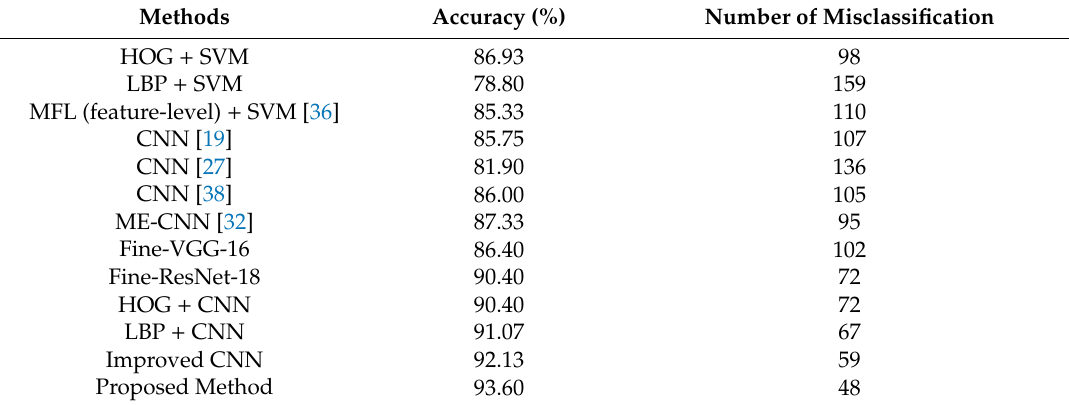
Table 8. Classification accuracy and number of misclassifications performed by di ff erent methods when applied to VAIS